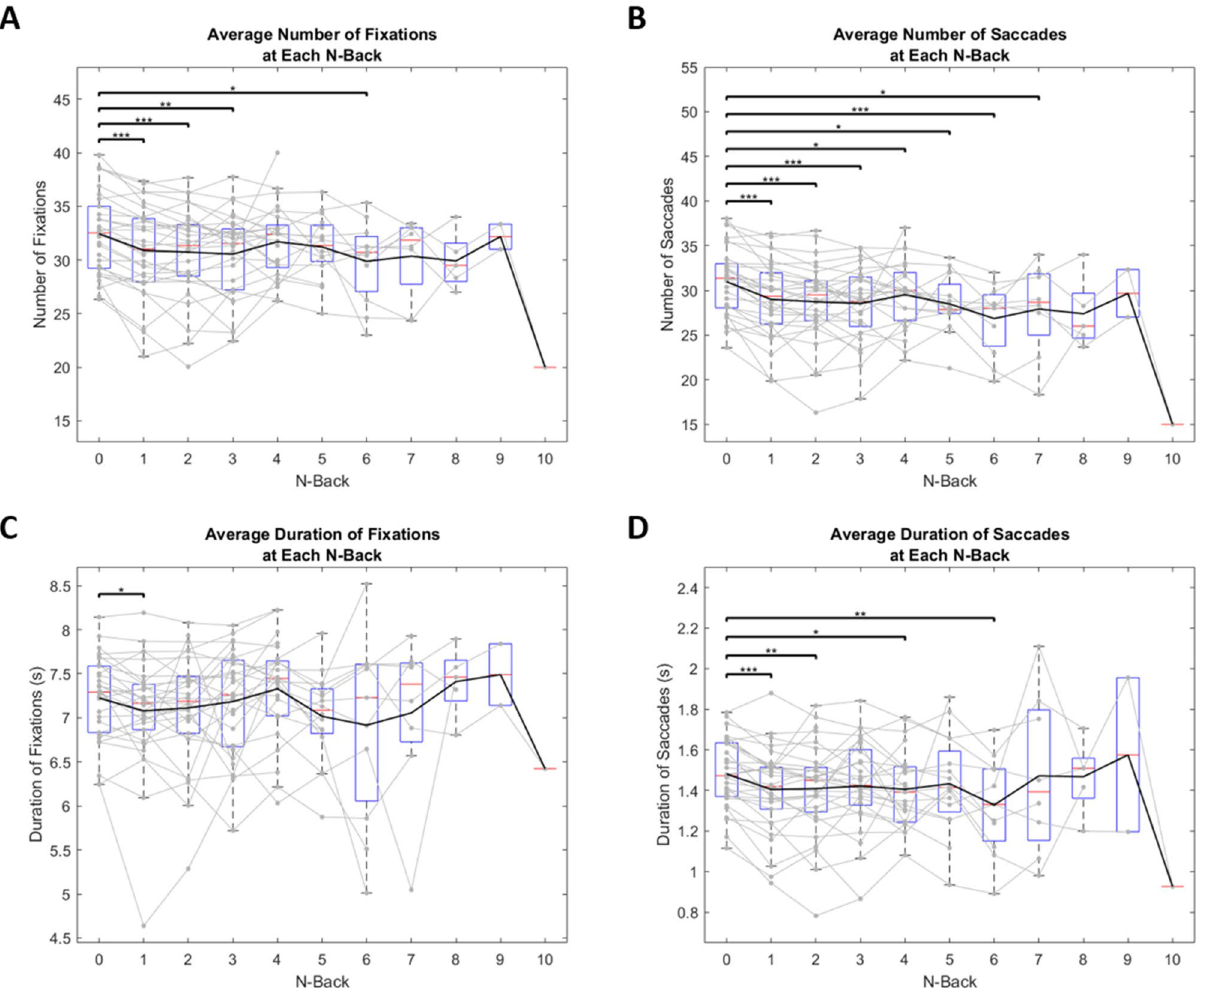
Figure 7. Average number (A&B) and duration (C&D) of fixations (A&C) and saccades (B&D) made by each subject at each N-back. Black line represents mean values. Solid gray lines represent individual subjects. Red lines represent median values. Blue boxes represent the IQR where each lower bound signifies Q1 and each upper bound signifies Q3. Lower and upper bounds of grey dotted lines represent minimum and maximum values, respectively. Points that lie outside these bounds are considered outliers. One star represents a significance value of p < 0.05, two stars represents a significance value of p < 0.01, and three stars represents a significance value of p < 0.001. For clarity, only interactions against N = 0 are plotted here. Number is represented as the total number of fixation or saccade events made during a trial. Duration is represented as the total cumulative sum of all fixation or saccade events during a